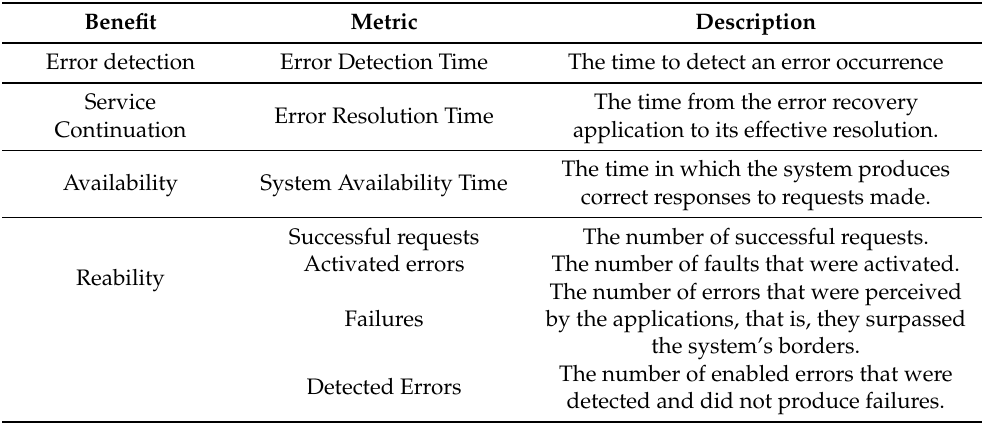
Table 2. Measures used to assess the benefit of using